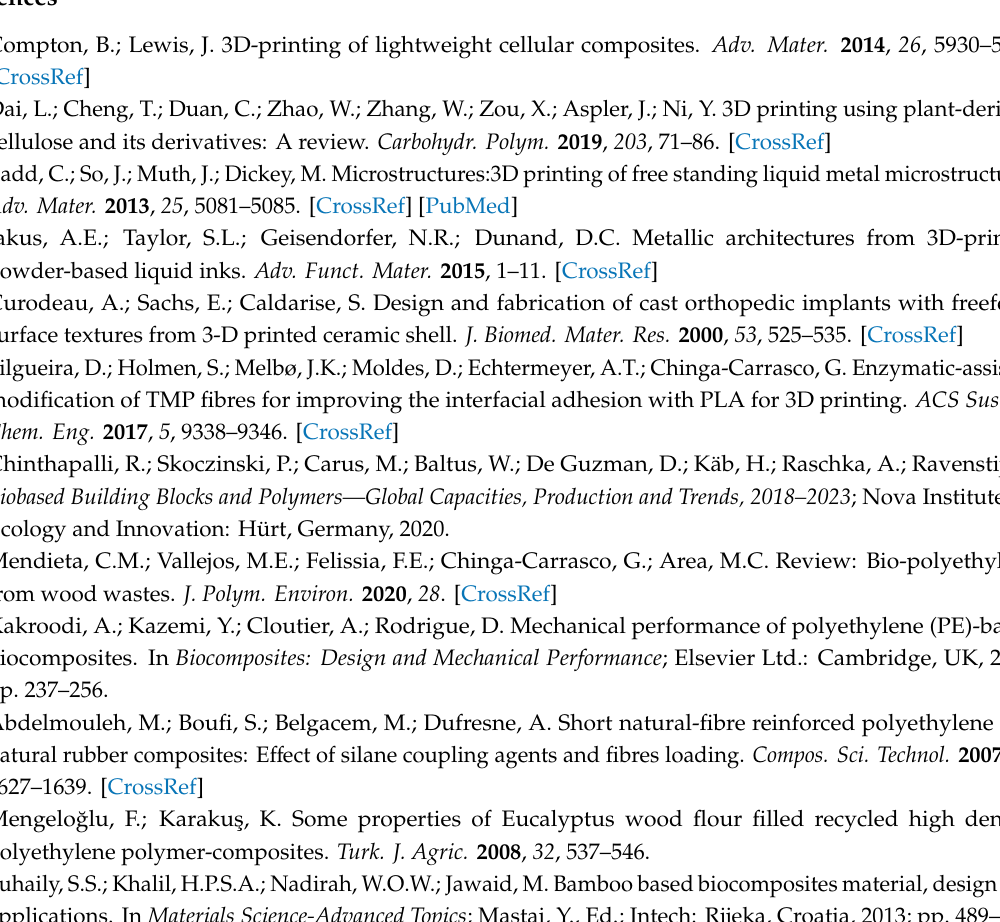
Supplementary Materials: The following are available online. Figure S1: Bagasse fibres, fracture areas of filaments (bagasse fibres and BioPE) and 3D printed tracks; Figure S2: Optical images of part of 3D printed layers. The images were acquired with an Epson Perfection scanner in transmission mode, 4800 dots per inch. From left to right) 20HT-F, 40HT-F, 20HT-B and 40HT-B; Figure S3: Graphical representation of the system boundaries for the production of sugarcane bioPE and fiber reinforced biocomposites. * Hemicelluloses are a by-product of the bagasse hydrothermal